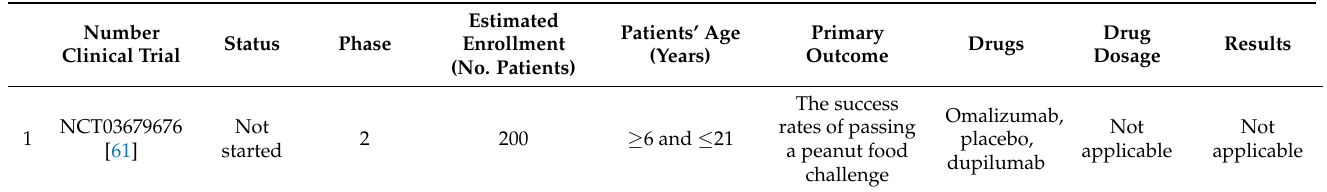
Table 4. Clinical development program for Omalizumab and Dupilumab as treatment in food